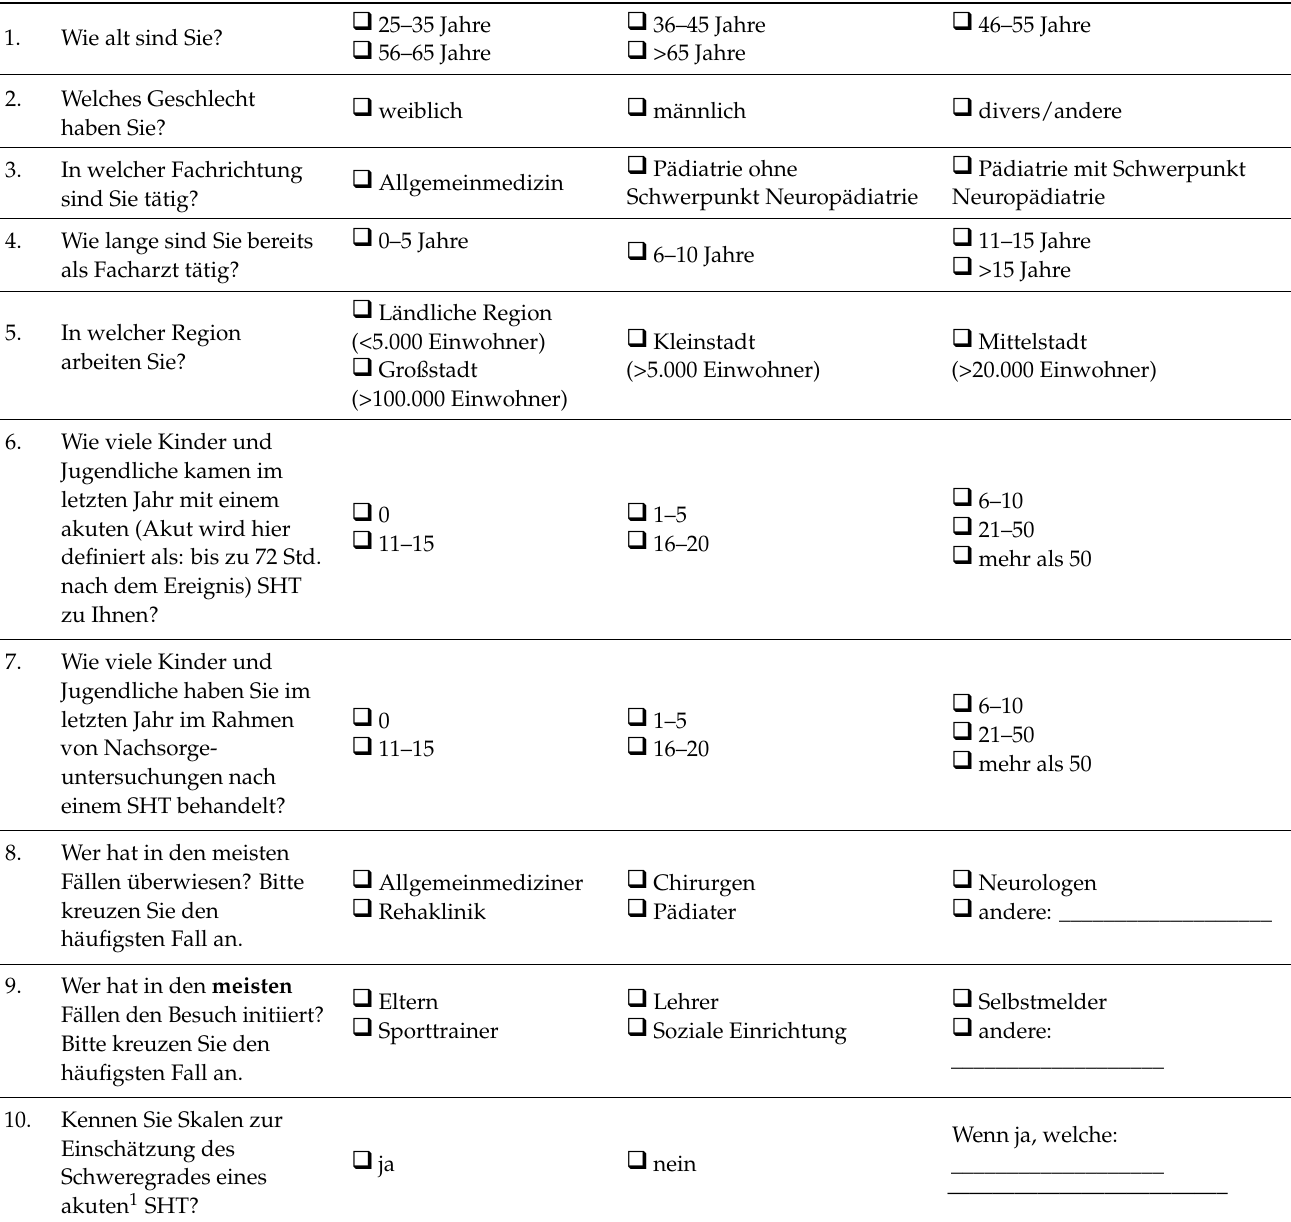
Welche Symptome können auf Spätfolgen (Spätfolgen wird hier definiert als: anhaltende Symptomatik 6 Monate nach dem Ereignis) eines SHT